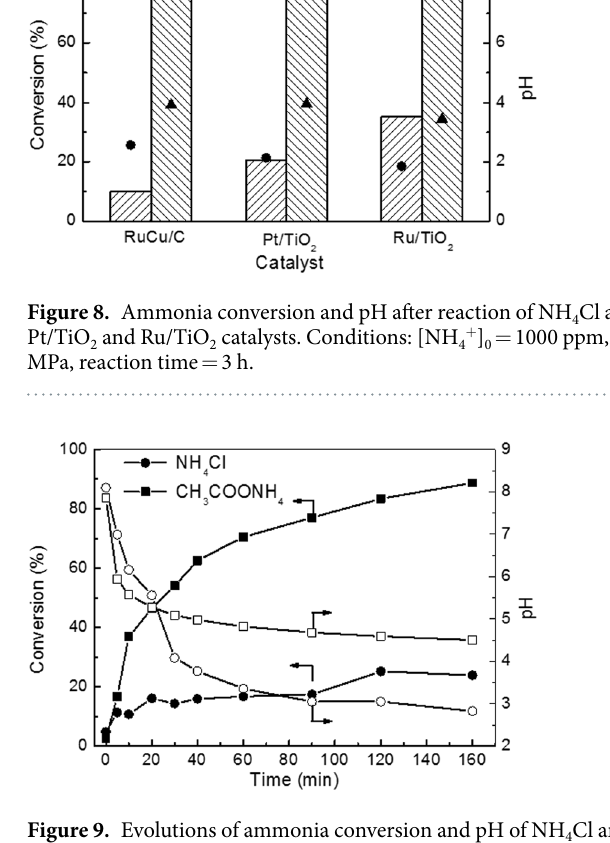
Figure 9. Evolutions of ammonia conversion and pH of NH 4 Cl and CH 3 COONH 4 solutions over Ru-Cu/C catalyst. Conditions: